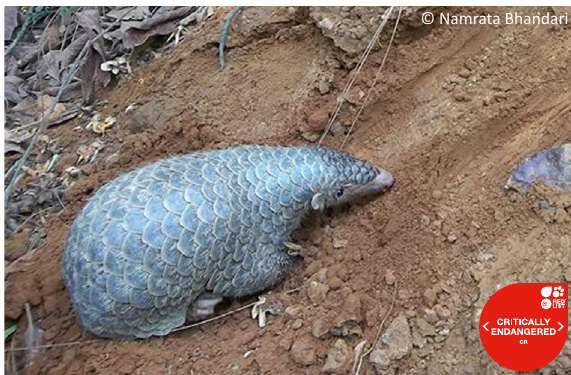
Image 1. Chinese Pangolin Manis pentadactyla